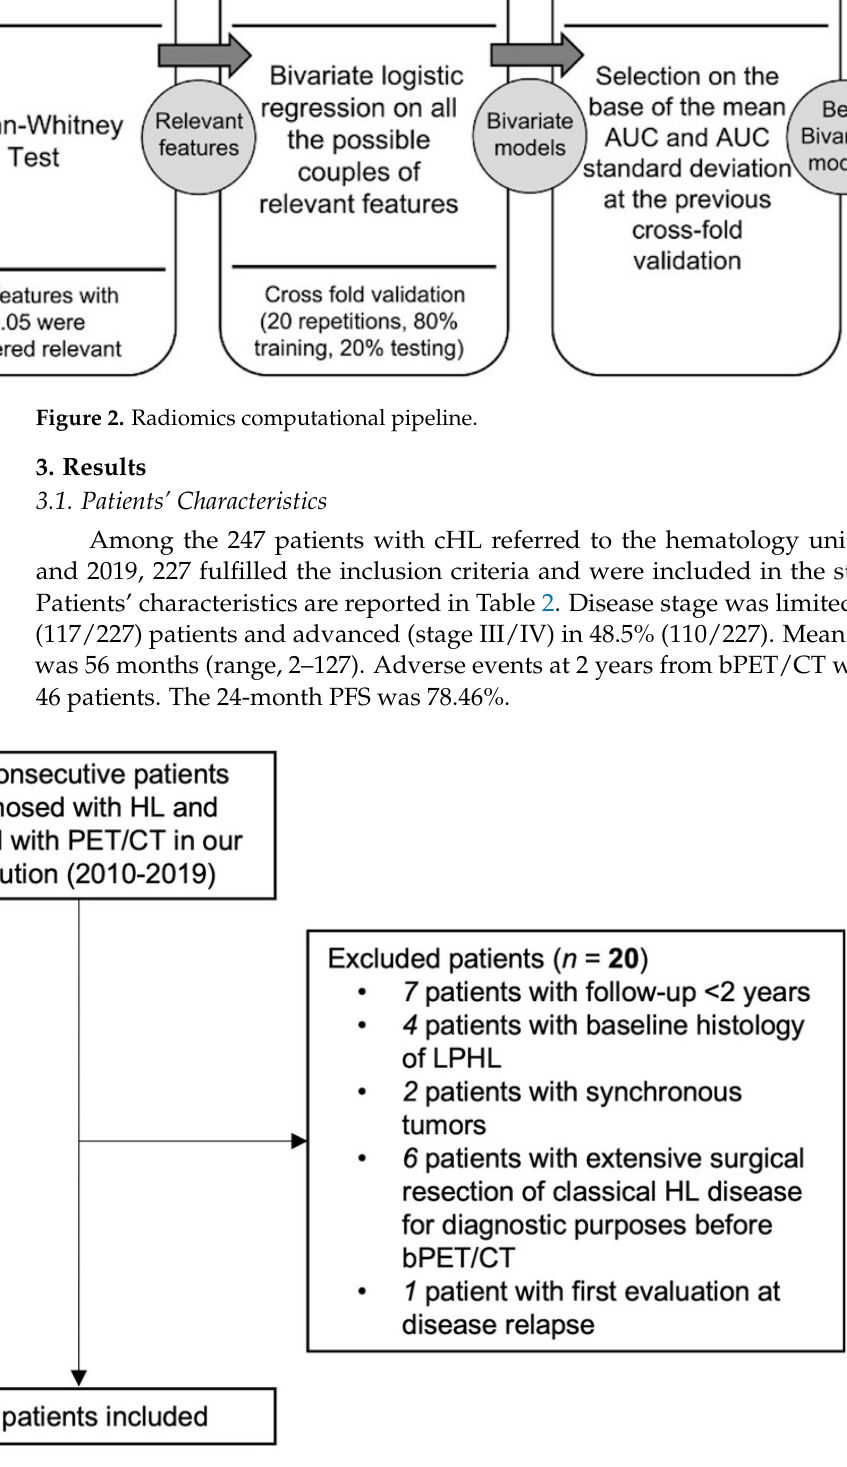
Figure 3. Flowchart of patients’ selection. HL, Hodgkin’s lymphoma; LPHL, nodular lympho- cyte-predominant HL.